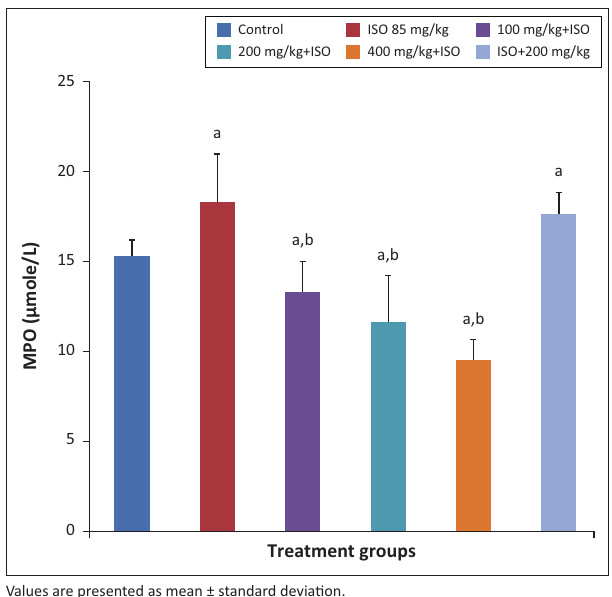
FIGURE 11: Effect of the ethanolic extract of Andrographis paniculata on lipid peroxidation in isoproterenol-induced myocardial infarction using rats as a model ( n = 5).